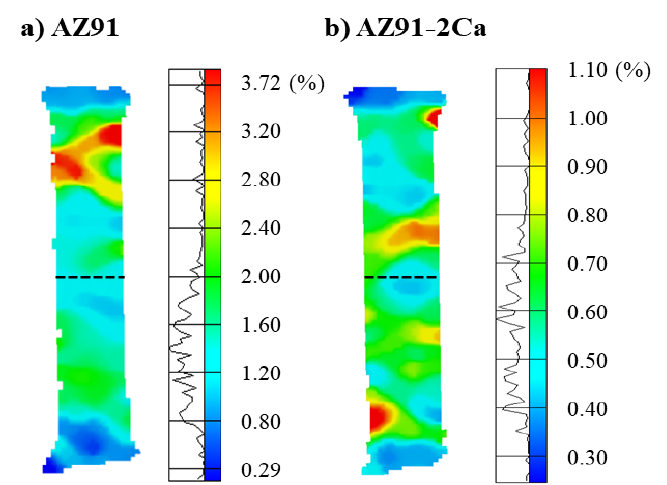
Figure 13. Surface strain map for the ( a ) AZ91/AZ91 and ( b ) AZ91–2Ca/AZ91–2Ca welds right before the final fracture during tensile testing. The black dotted line shows the joint interface. In both welds, fracture occurred in the area of strain localization, outside the weld region (i.e., in the base material